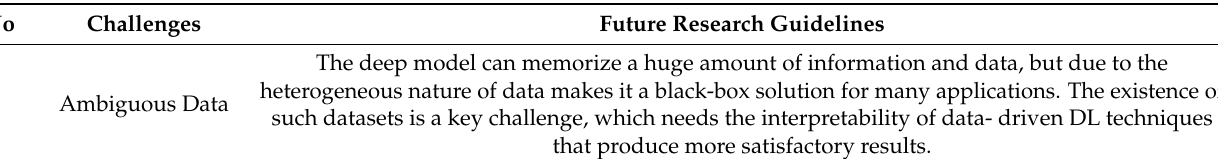
Table 7. Summary of diverse challenges and their future